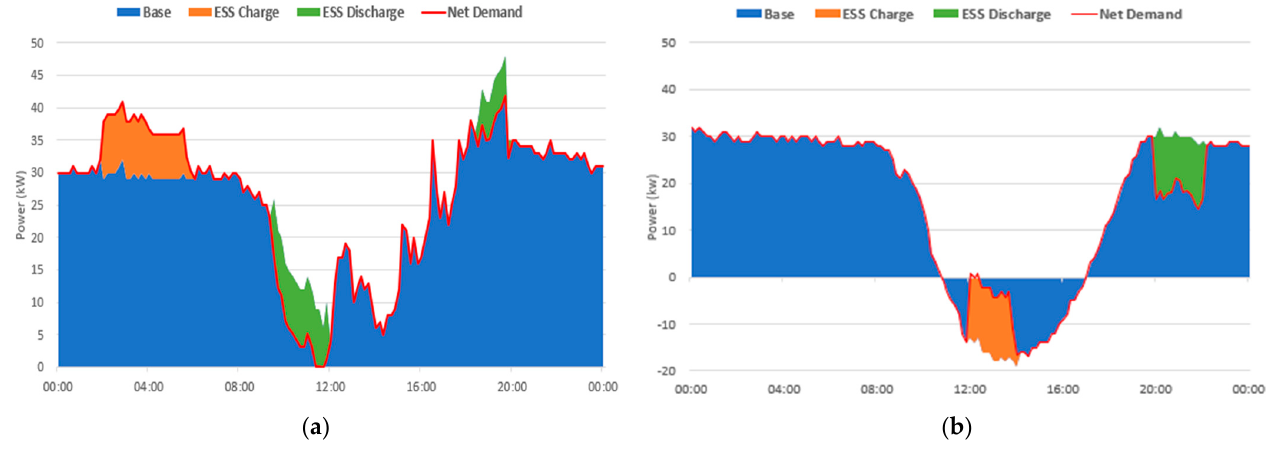
Figure 9. Scenario A: weekday ( a ); weekend ( b ).